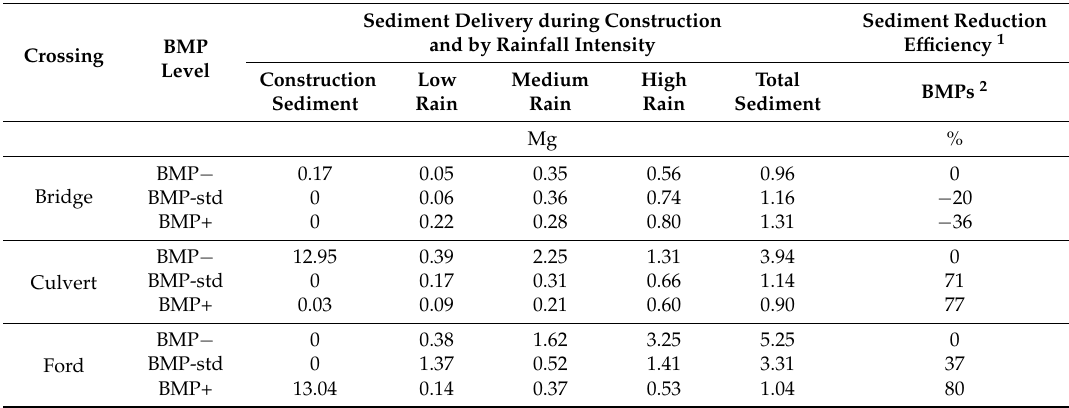
Table 6. Total sediment delivery by crossing and BMP level during rainfall simulations and sediment reduction efficiency by BMP level for each